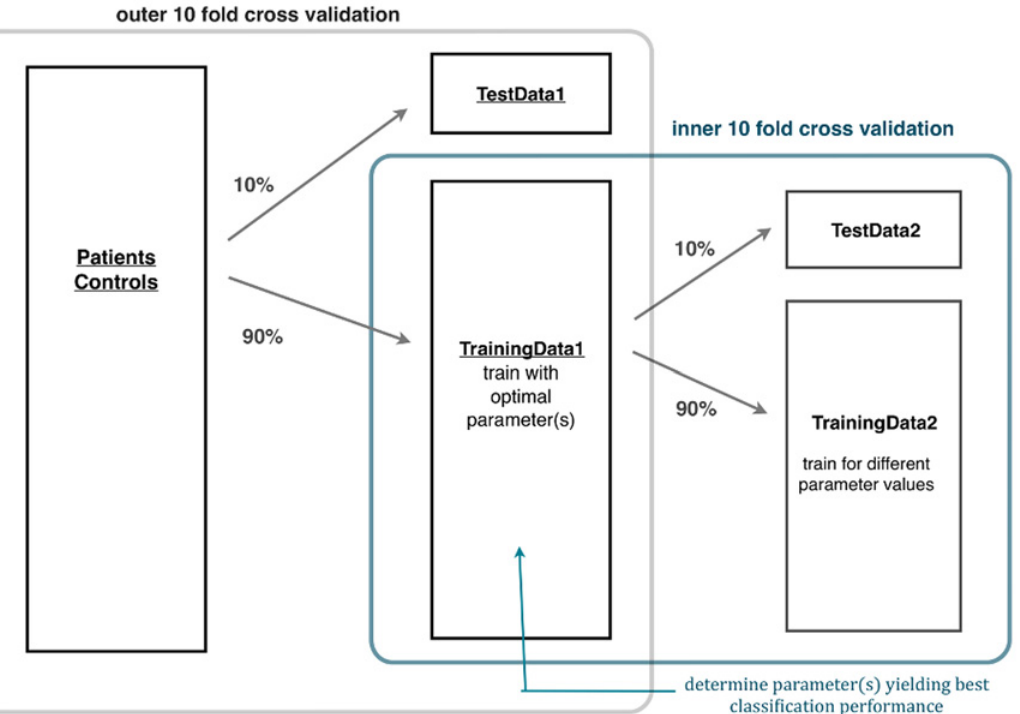
Fig 2. Nested 10-fold cross-validation. 10% of the data were defined as test dataset (TestData1) while the remaining 90% (TrainingData1) were used to evaluate the best performing regularization parameter λ opt (= λ Sopt in the case of sLASSO, = λ Gopt in the case of gLASSO, = ( λ Sopt , λ Gopt ) in the case of sgLASSO) in a 10-fold cross-validation (inner 10-fold cross-validation). Parameters thus determined were then used to train TrainingData1 and to evaluate the final performance using TestData1. The same procedure was repeated ten times, altering the set of train and test data each time, so as to complete a 10-fold cross-validation (outer 10 fold